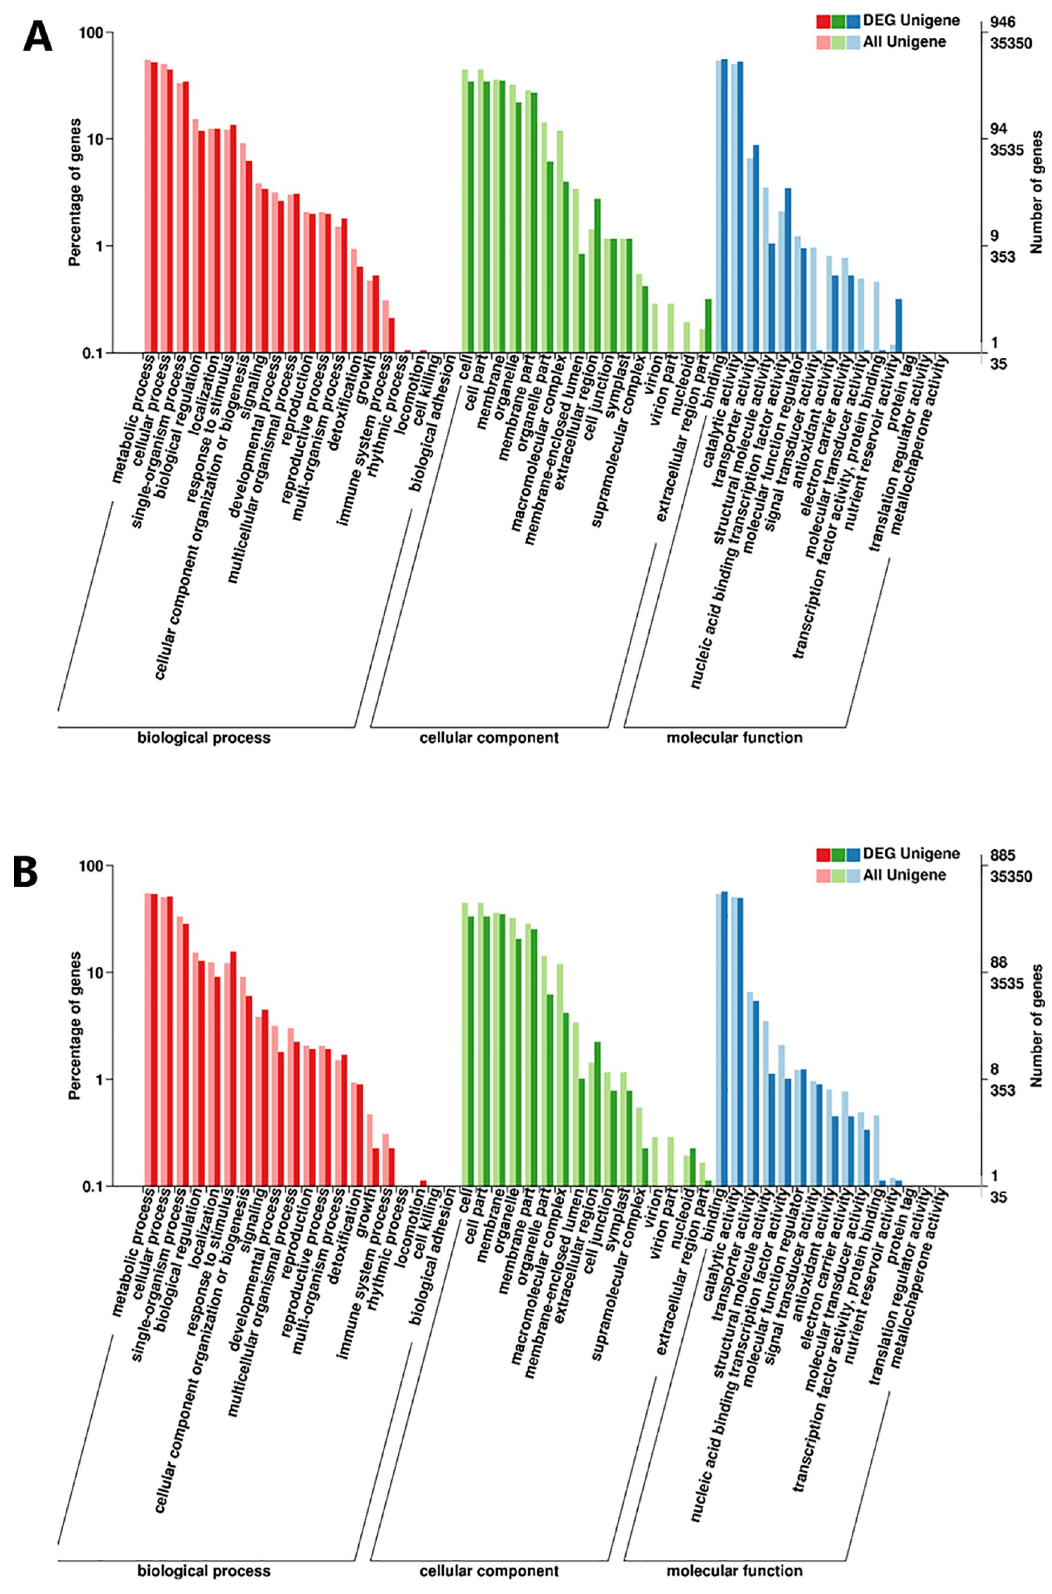
Fig 5. GO classification of all DEGs in purple and green SYQ leaves. Upregulated genes (A) and downregulated genes (B).